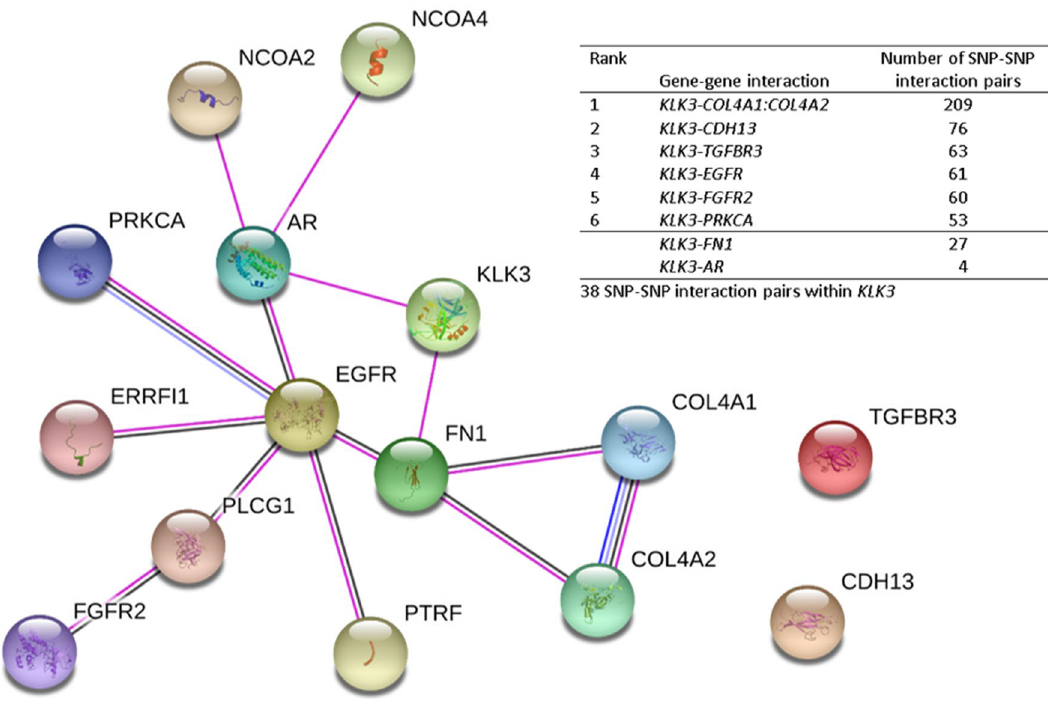
Figure 5. KLK3 gene–gene interaction network based on common genes interacted with KLK3. KLK3 and AR are in the androgen pathway. All other genes in the table are in the angiogenesis pathway. SNP single-nucleotide polymorphism. The gene–gene interaction network plot was generated using the STRING software (https:// string- db.